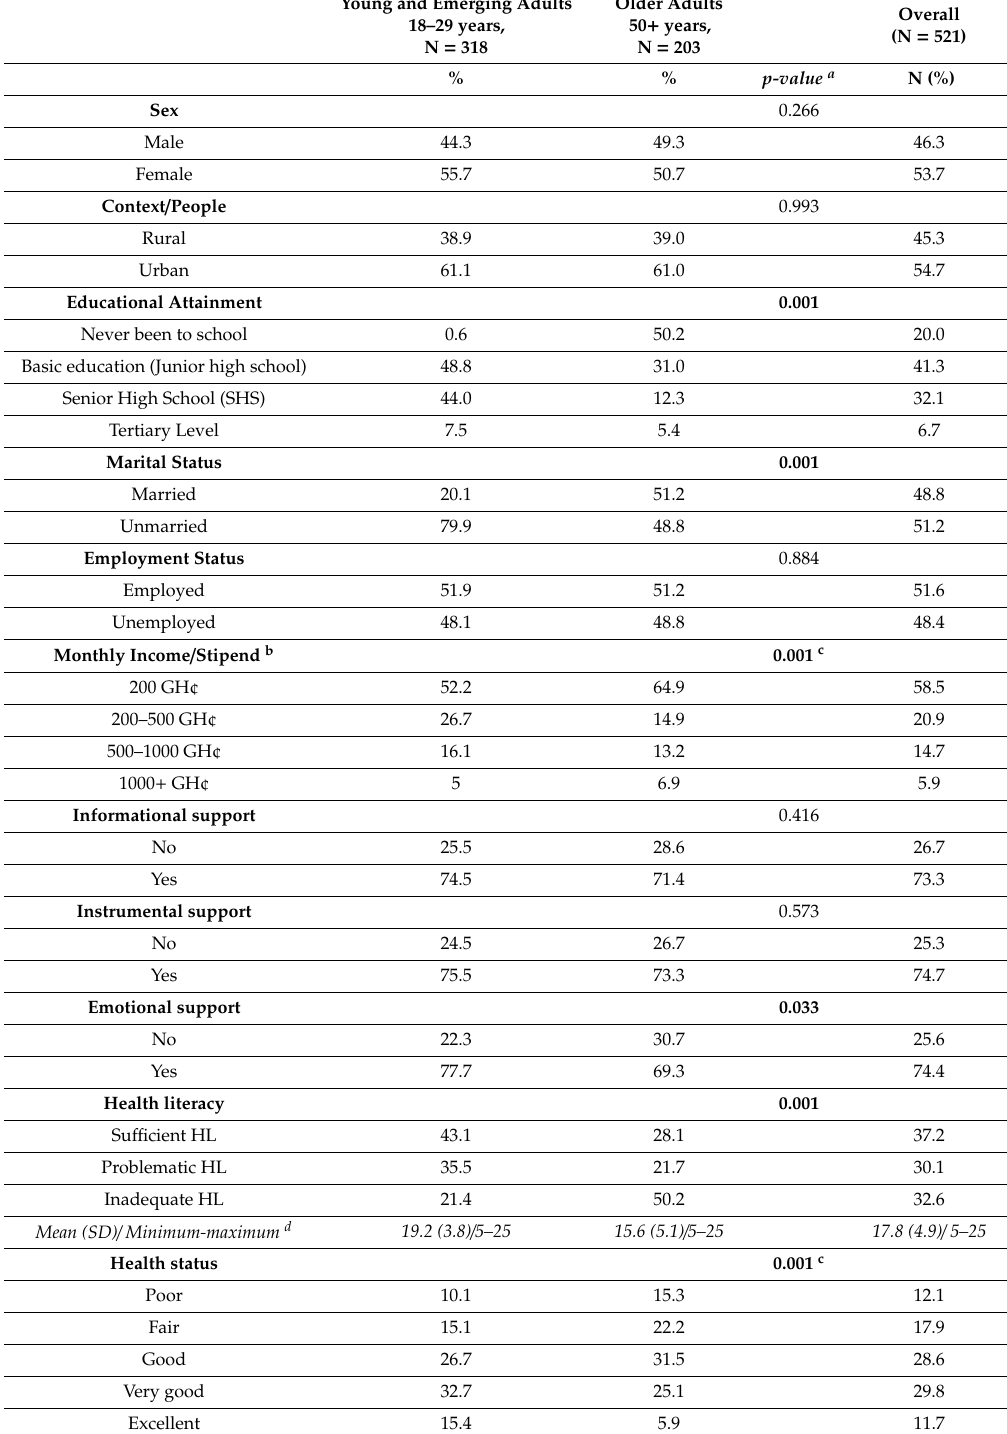
Table 1. Sociodemographic characteristics of